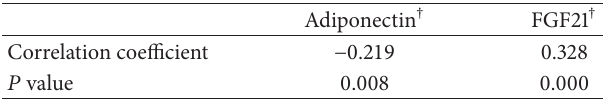
Table 6: Kendall’s tau-b correlation between circulating levels of CTRP1, adiponectin, and